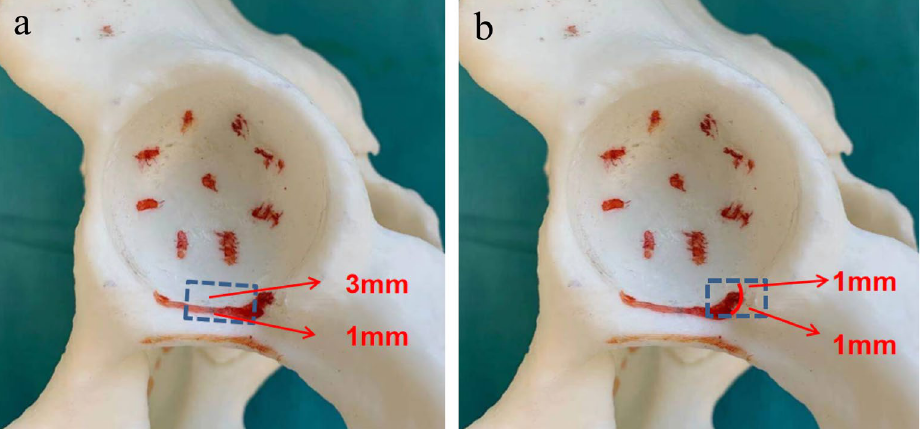
Figure 8. ( a ) Intraoperative positional safe zone range of cup’s inclination; ( b ) intraoperative positional safe zone range of cup’s